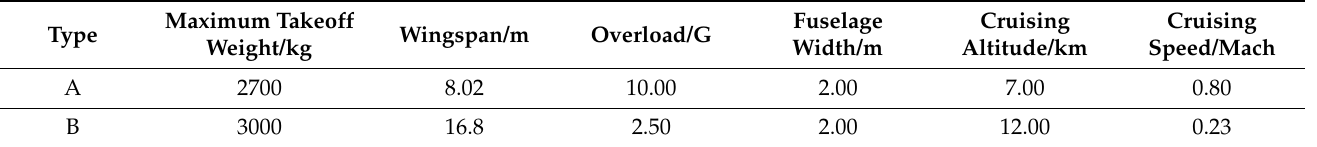
Table 4. The basic data of the modular aircraft.